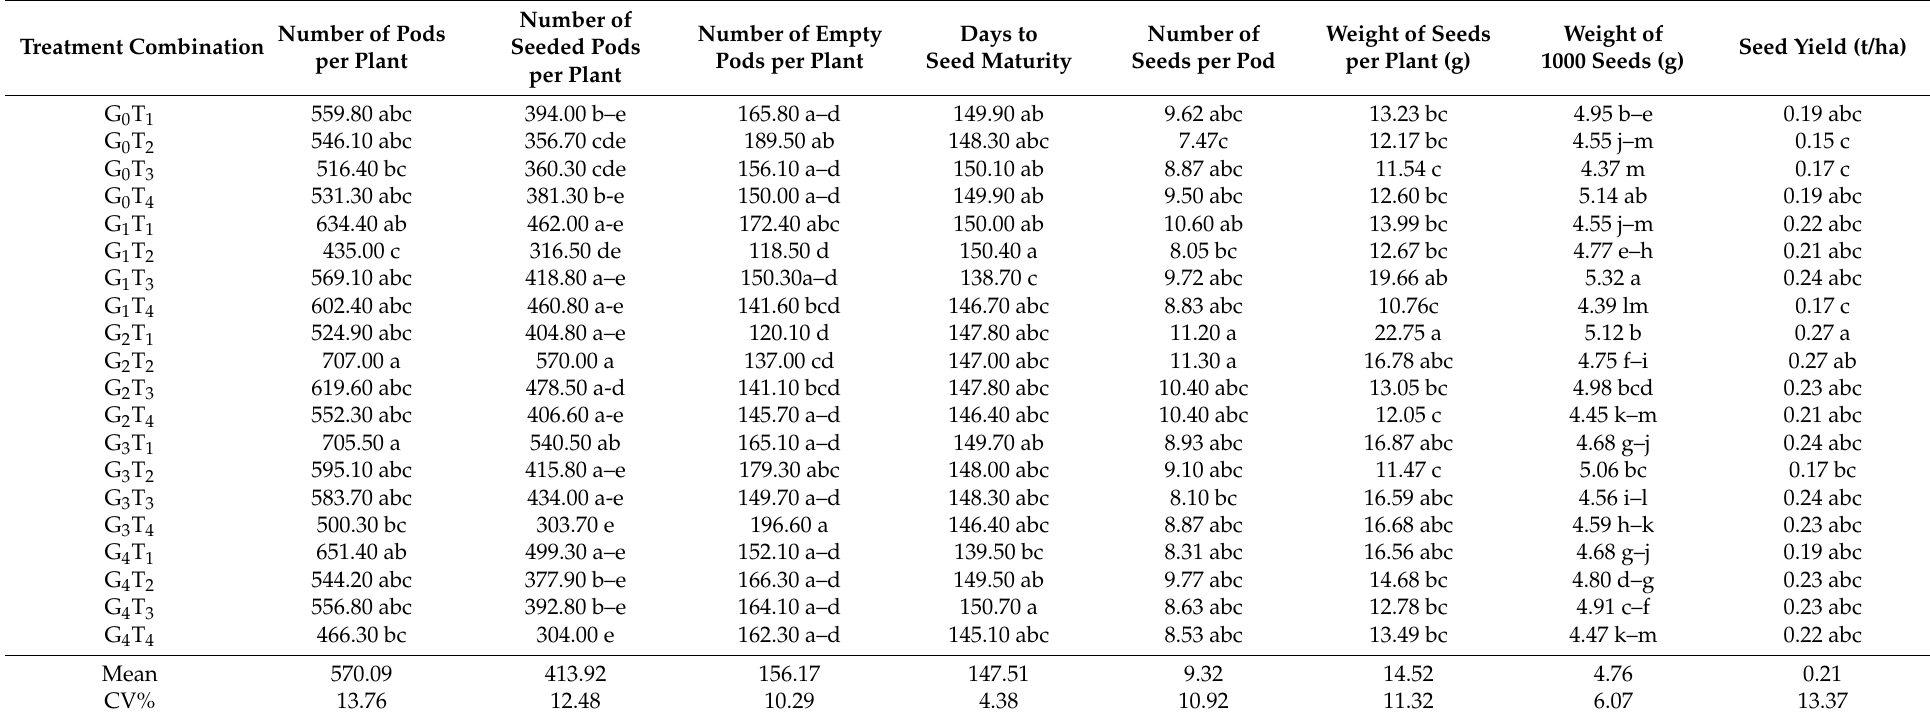
Table 6. Interaction effect of GA 3 and time of application on seed yield and its contributing traits in BU